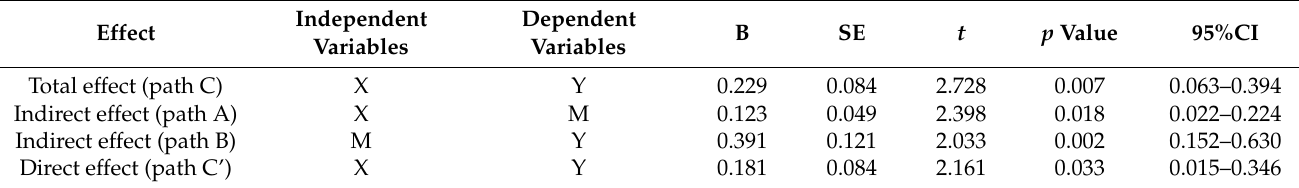
Table 3. Summary of the mediating effects of self-efficacy between acculturation and respite care knowledge ( n =